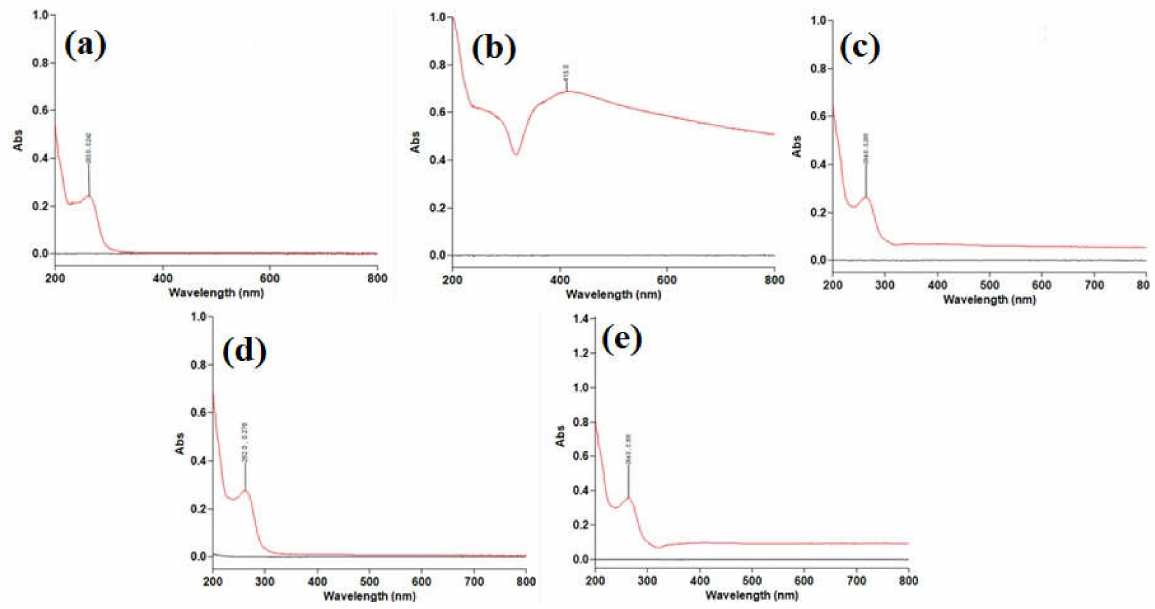
Figure 1. UV-Visible spectrum in the range 200–800 nm of ( a ) INH, ( b ) AgNPs, ( c ) F7, ( d ) F10, and ( e ) F13 λ max is indicated in each